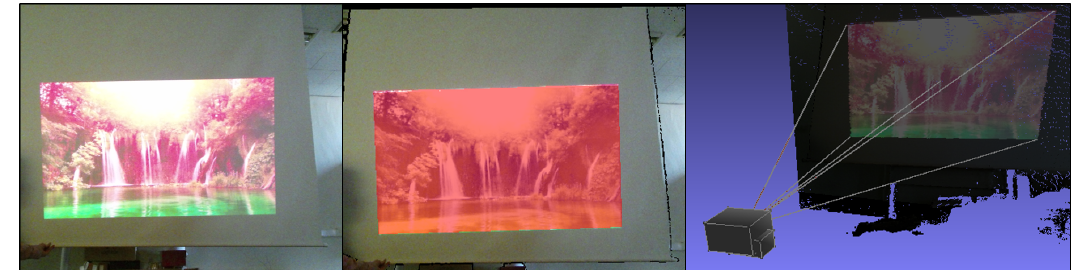
Figure 5. An example of the projection surface masks M s ( x , y ) obtained by Equation (4). The left image is a captured image with the projection and its background. The red region of the center image represents the projection surface masks. The right image shows the projection surface masks (colored regions) in 3D projector coordinates with five projection rays (white lines) at the boundaries and